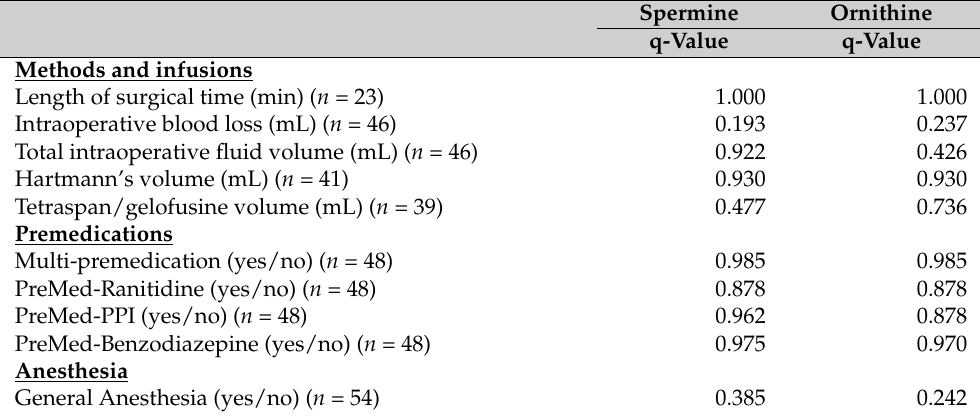
Spermine Ornithine q-Value q-Value